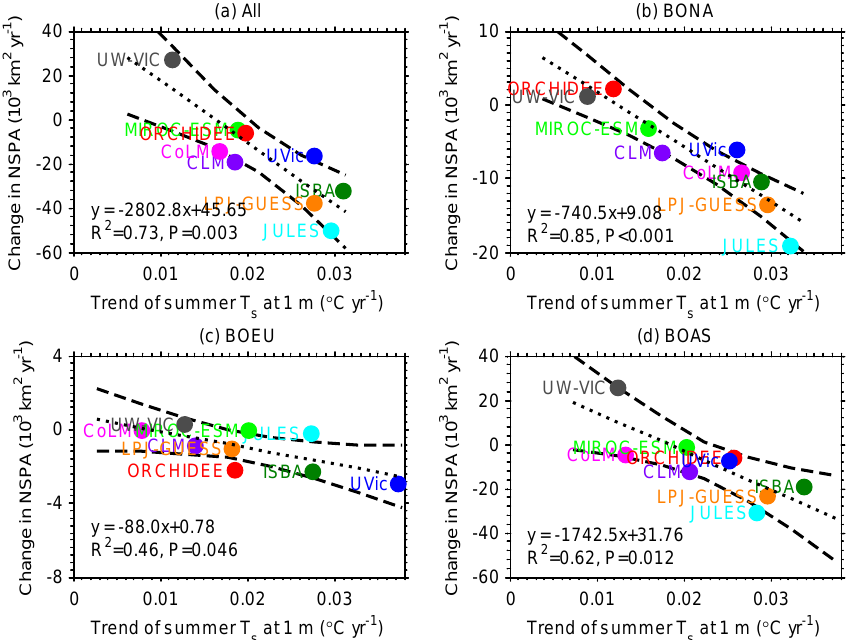
Figure 9. Simulated trends of summer T s at 1m and loss rate of NSPA over (a) boreal regions, (b) BONA, (c) BOEU, and (d) BOAS across the nine